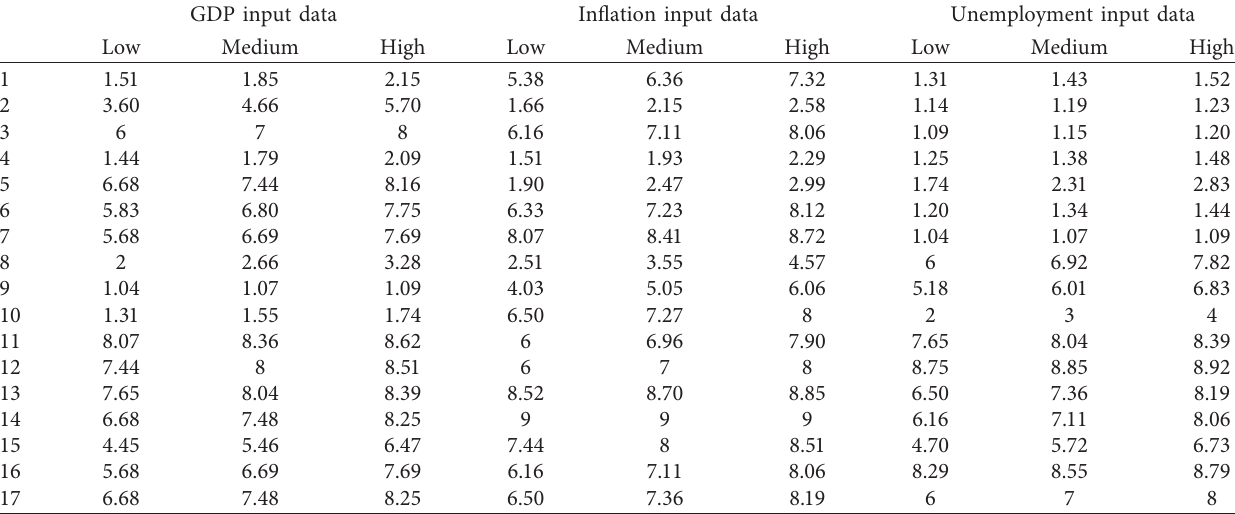
Figure 1: Fuzzy logic system. Table 2: Fuzzy input data.